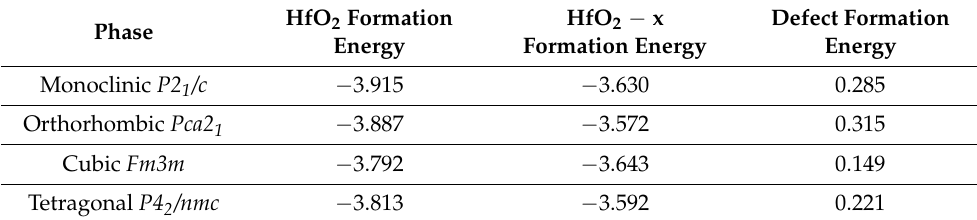
Table 2. Defect formation energies in eV of HfO 2 polymorphs.